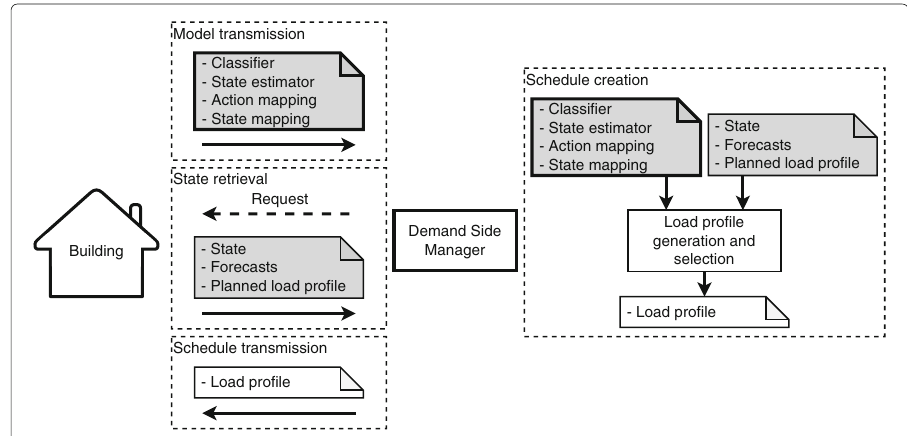
Fig. 1 Provision and utilization of the flexibility model (cf. (Förderer et al. 2018b)). Information generated by the EMS is depicted with a gray background and static information with an additional bold